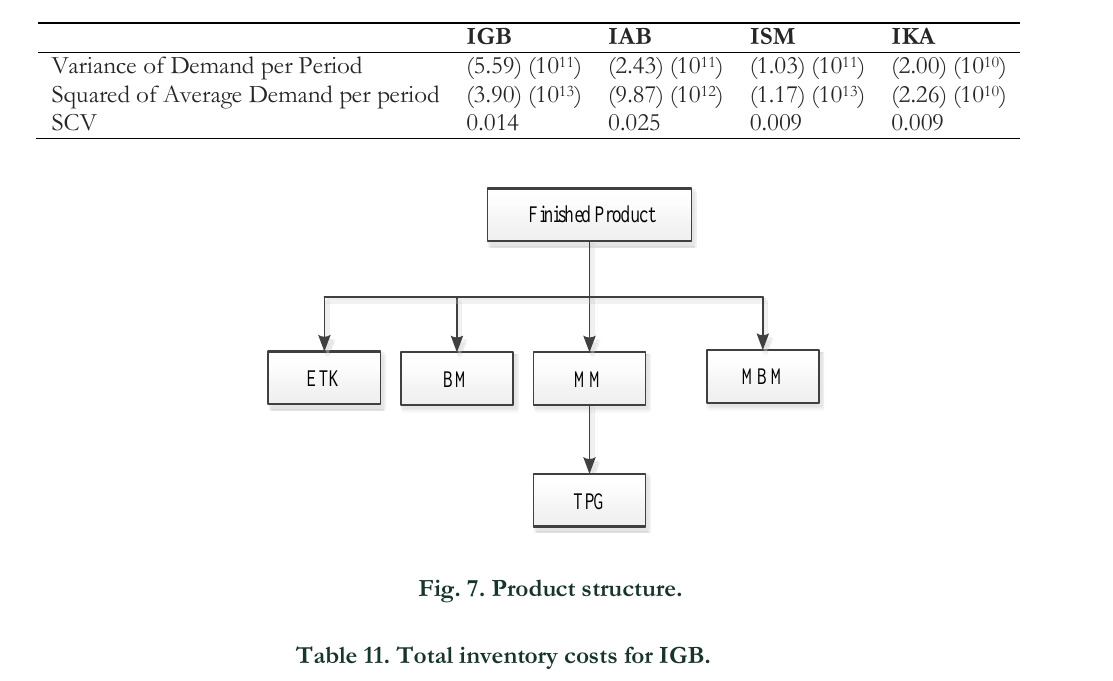
Table 10. SCV results.